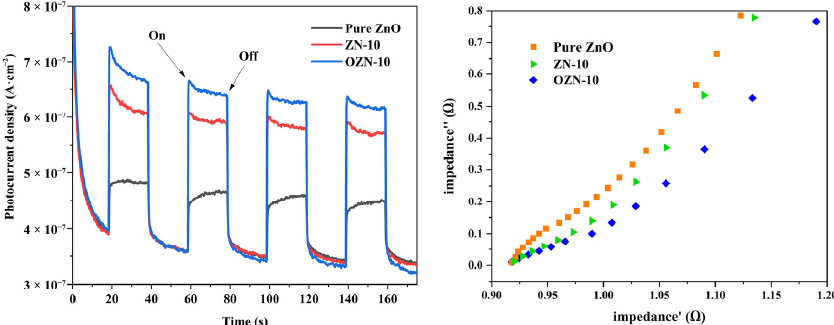
Figure 11. Photoelectrochemical properties of pure ZnO, ZN-10 and OZN-10 and ( a ) photoresponse diagram of time amperometry. ( b ) Nyquist plot of electrochemical impedance.